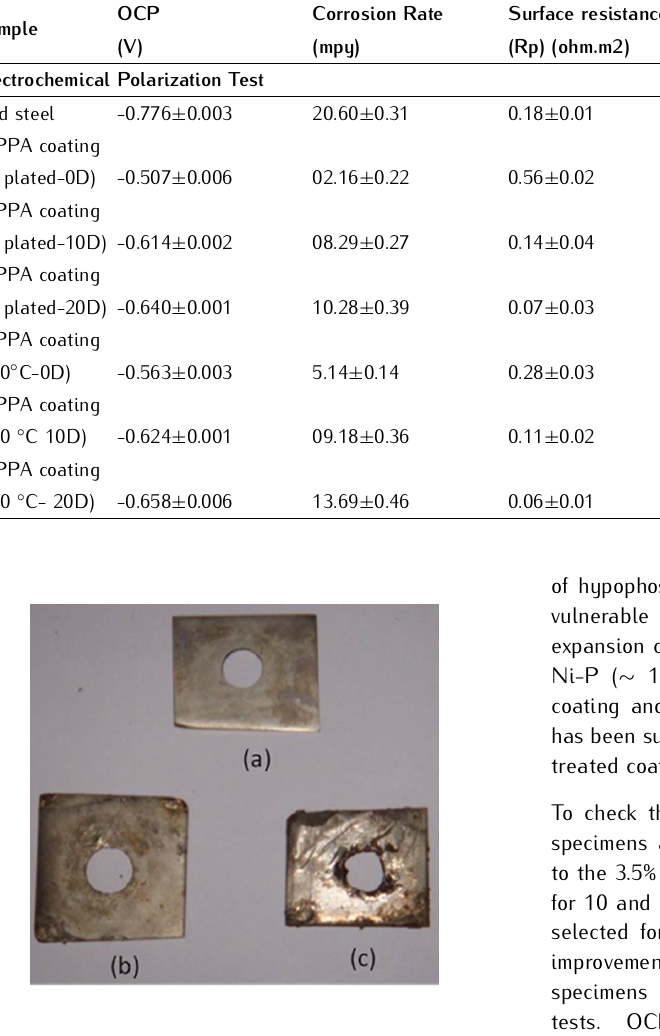
Figure 6. Photographs of as plated sample (a) before immersion test, (b) after immersion test and (c) 400 ◦ C heat treated samples after immersion